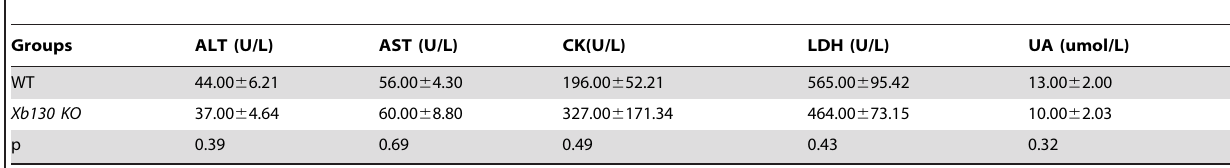
Table 3. No significant differences of blood biochemistry between Xb130 KO and WT mice.